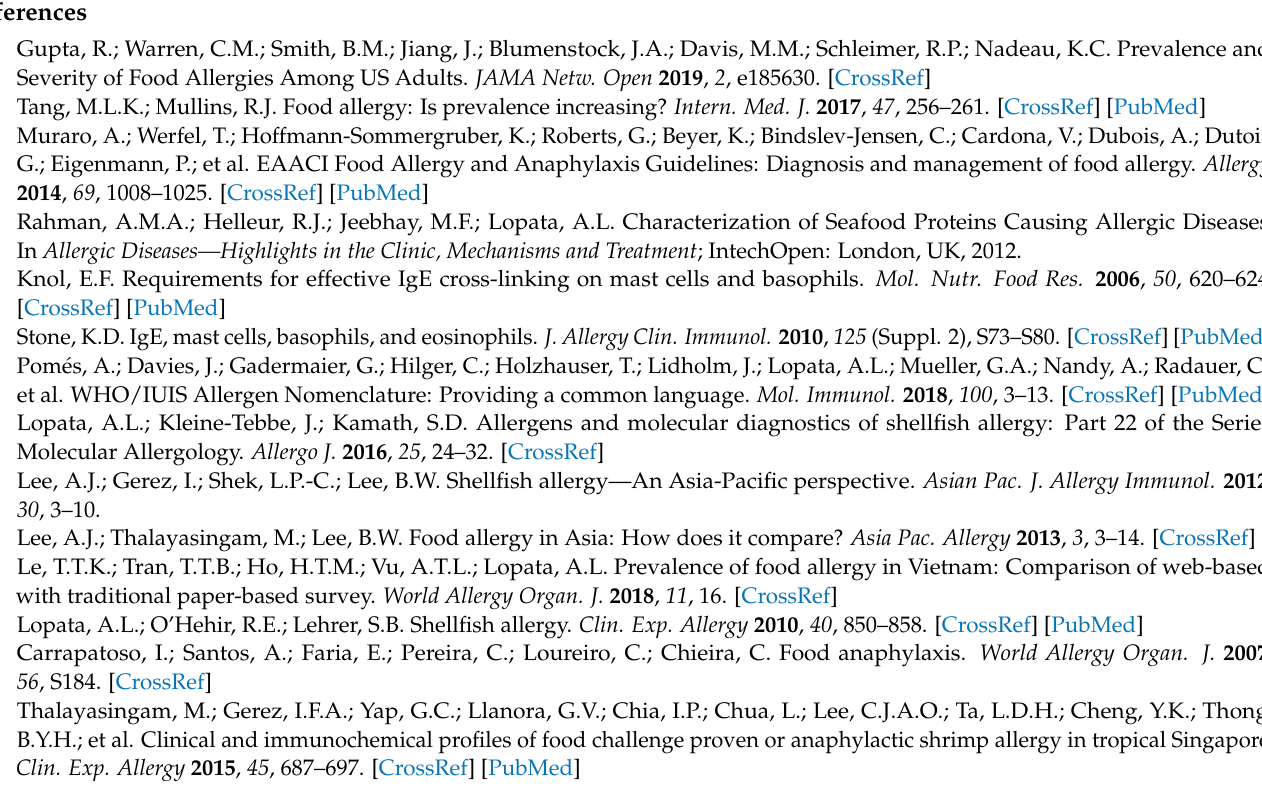
sequence identities were calculated using multiple sequence alignment in Clustal Omega (EMBL-EBI). Figure S10. Multiple sequence alignment of triosephosphate isomerase (TIM) allergen. Sequences consist of (1) known shrimp TIM allergen, (2–6) contigs from five shrimp species that matched with TIM allergen and (7–8) TIM allergen sequences from house dust mites. Multiple sequence alignment was conducted in Jalview 2.1 using Clustal Omega. Table S1. Criteria used in the BLAST search. The criteria shown here are only for the BLAST search utility within the Geneious™ software. Additional search criteria (for this project) were later used in the refining process of the search results, e.g., Minimum % Pairwise Identity of